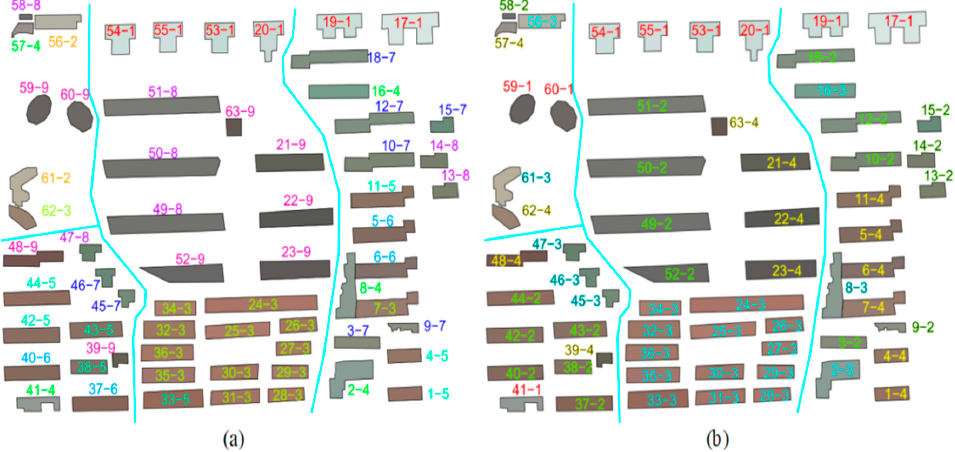
Figure 8. Texture classification in the ( a ) global region and ( b ) local region.